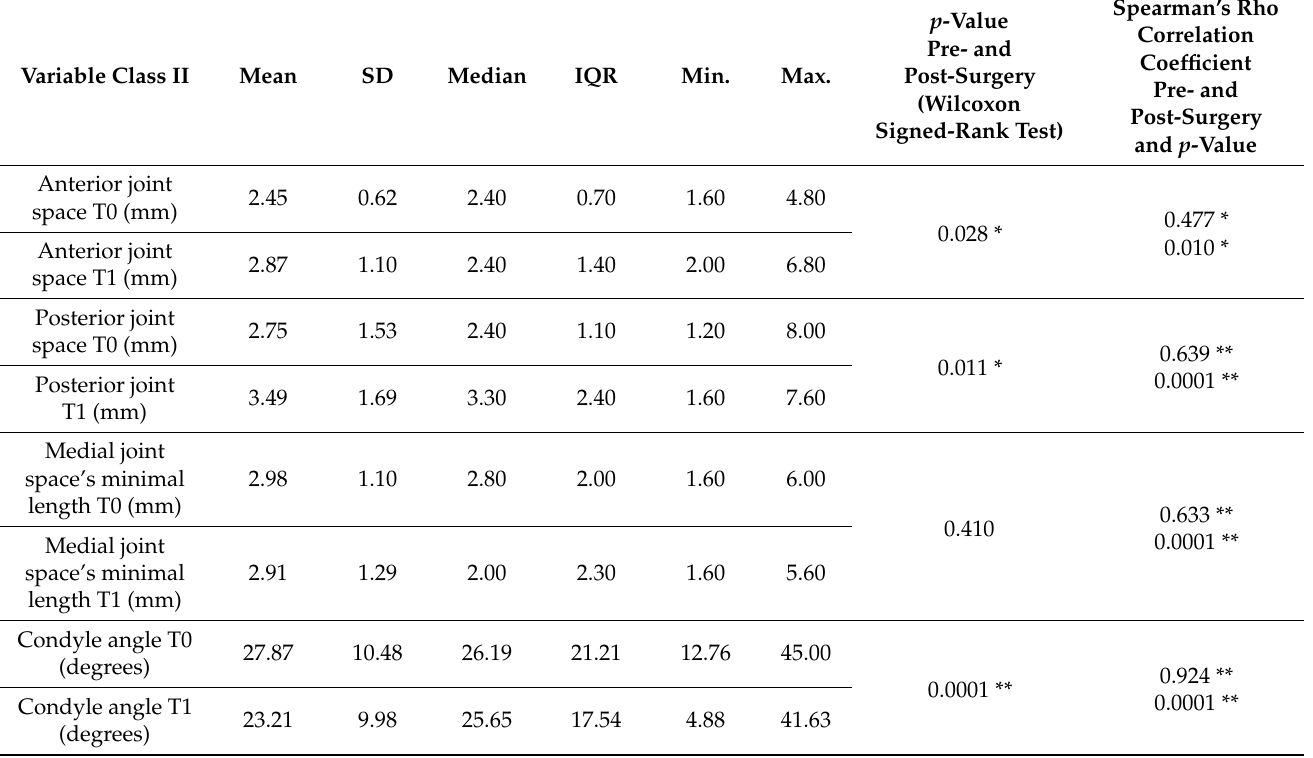
Table 1. The characteristics of the studied variables in class II malocclusion patients ( n = 28).